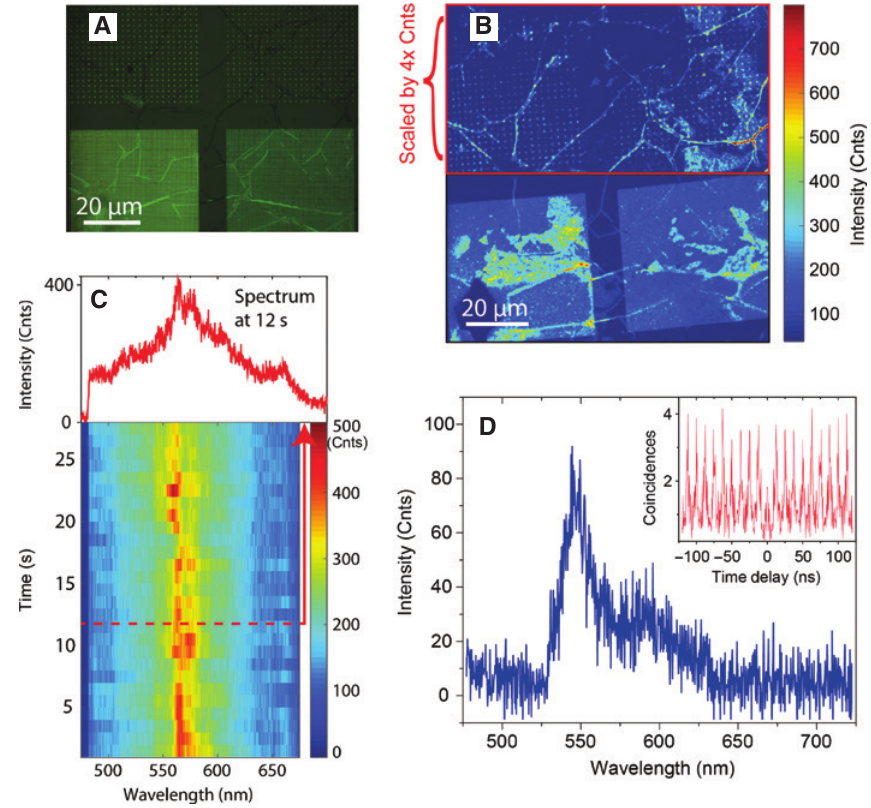
Figure 3: Confocal collection of emission of hBN on Ag pillars arrays. (A) The optical microscope image of the hBN-draped Ag pillar arrays. The particle diameters are 400 and 300 nm for the pair of arrays in the left and the right halves, respectively; the arrays in the upper and lower halves have a lattice period of 2 μ m and 620 nm, respectively. (B) The hBN photoluminescence for the same region as in (A). For clarity, we use different color scales for the arrays in the upper and lower halves. (C) The time-resolved emission spectra from a point on the array with 430 nm pitch and 100 nm pillar diameter. Several emitters are seen alternating between the bright and dark states in the 550–675 nm spectral band. The upper spectrum (red trace) corresponds to a line cut at 12 s. (D) The spectra from an isolated 100 nm-diameter pillar from a 2000 nm-pitch array. The phonon sideband is clearly visible ~ 165 eV from the zero-phonon line at 550 nm (blue trace). Inset: The photon correlation data via a pulsed Hanbury-Brown-Twiss measurement; an autocorrelation value g (2) (0) = 0.54 was determined from the curve, implying 2 or less emitters.